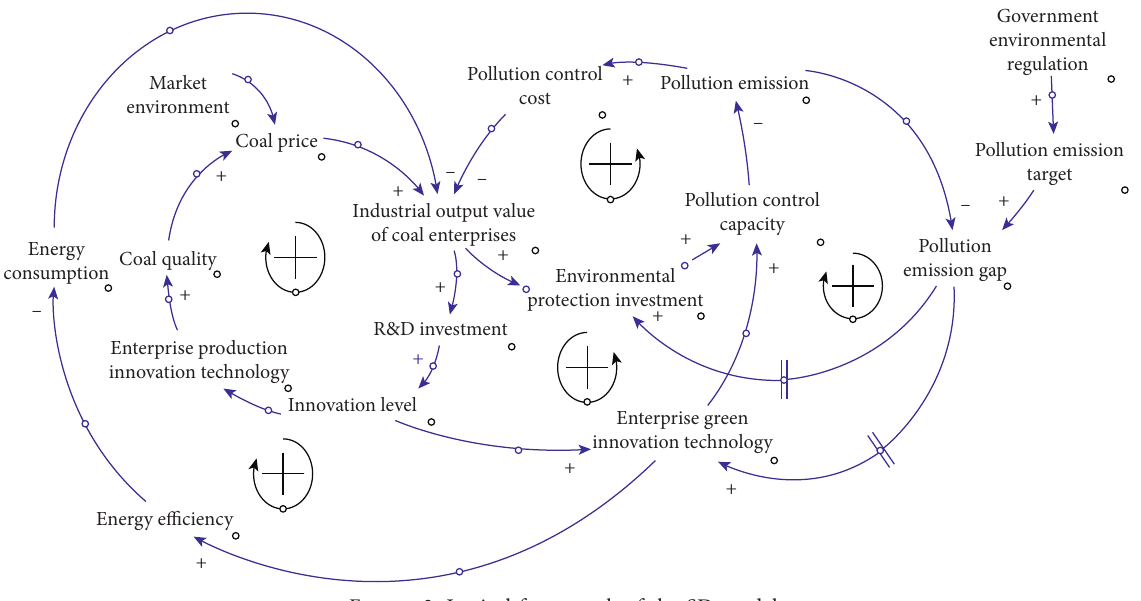
Figure 2: Logical framework of the SD